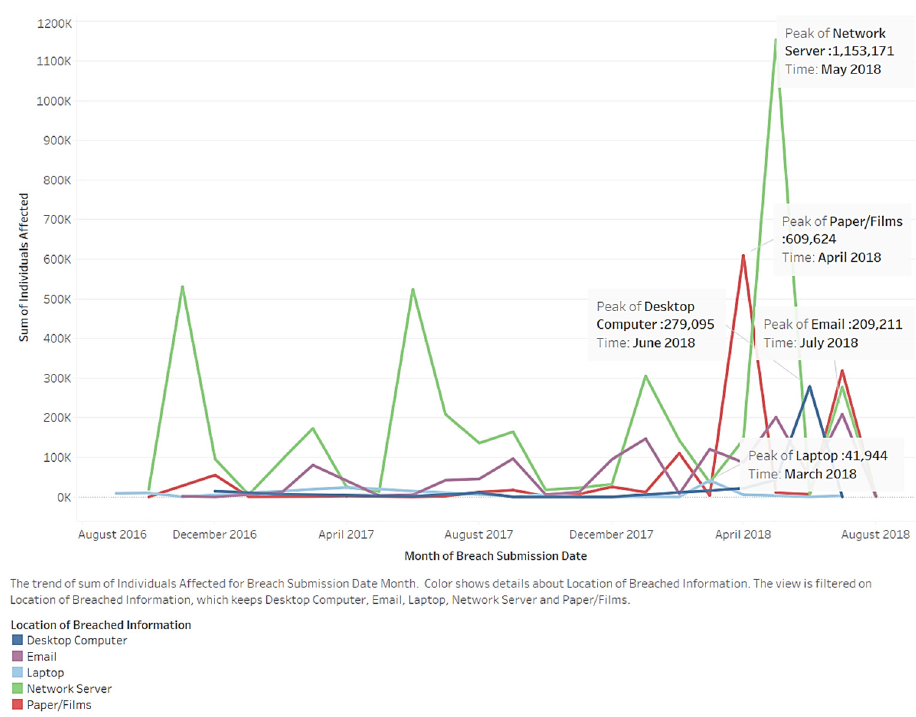
Figure 15. Trends related to affected individuals by breach and location of the breached information.